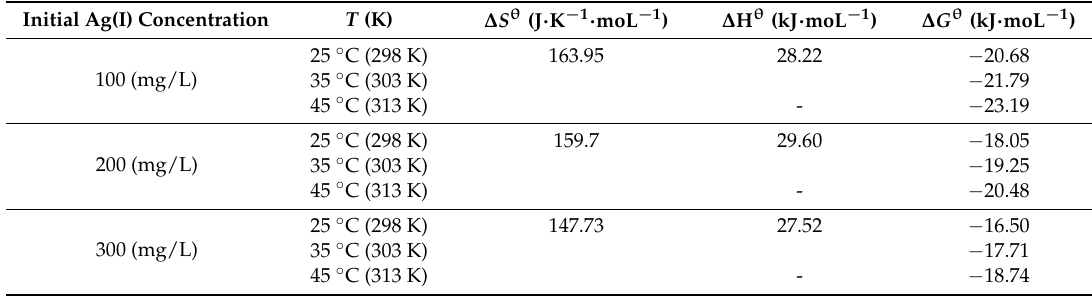
Table 7. Thermodynamic parameters of Ag(I) adsorption onto